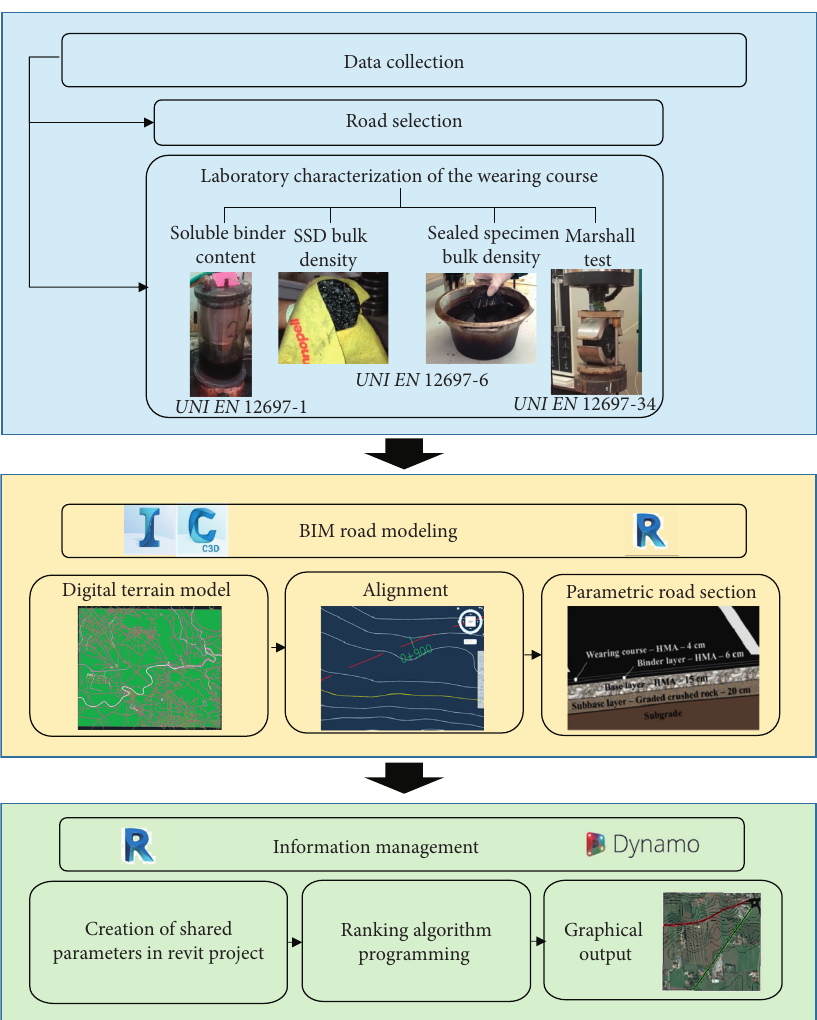
Figure 1: Methodology overview.